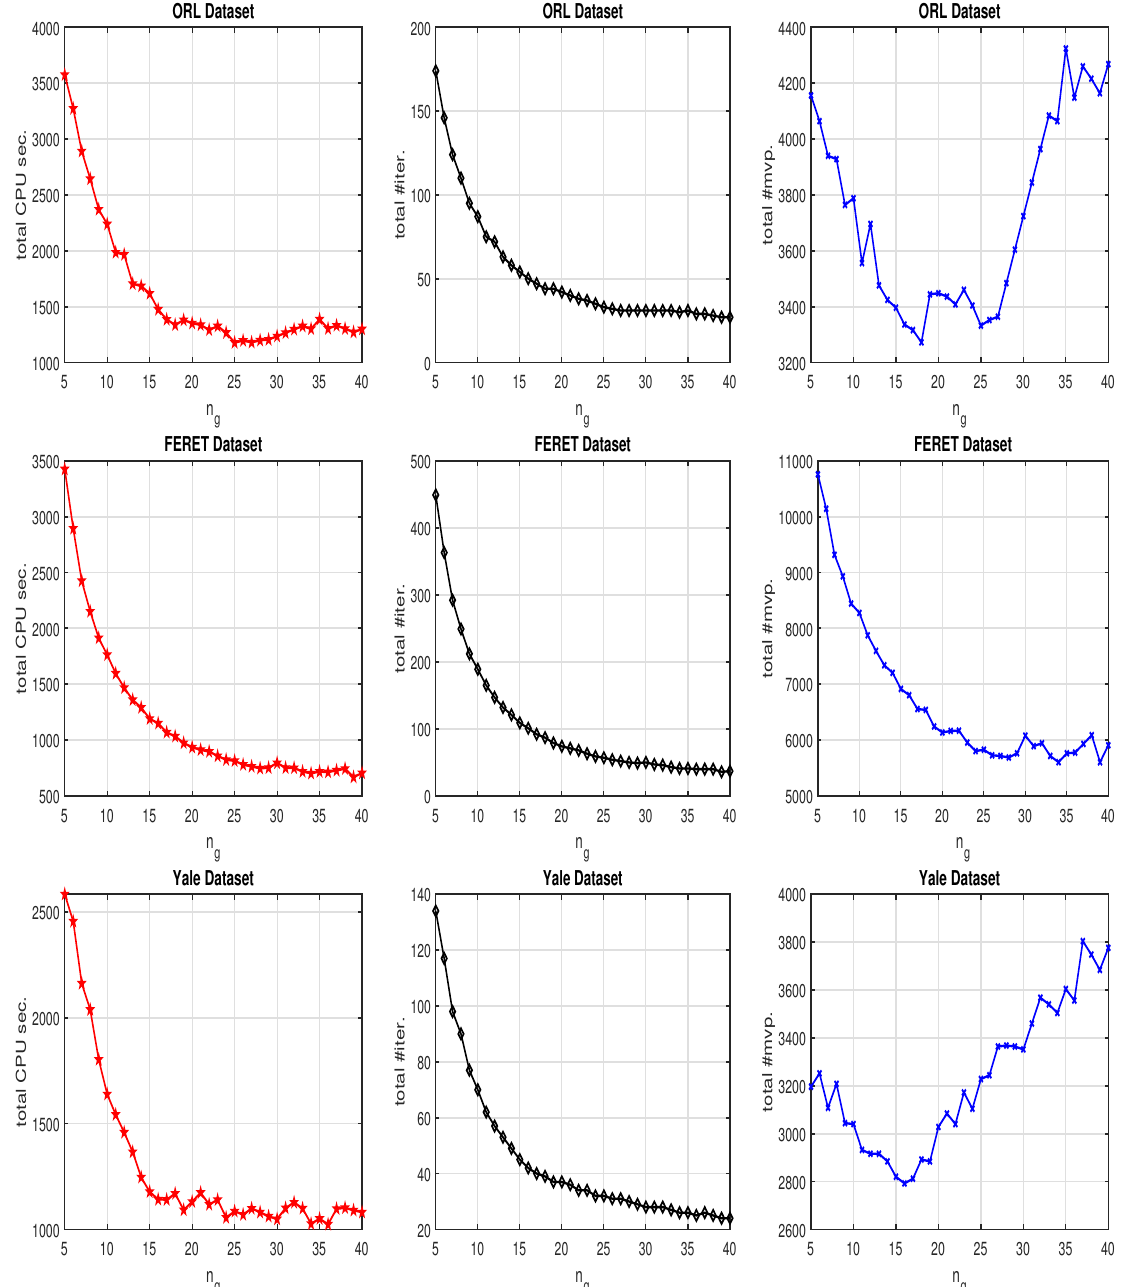
Figure 2. Cost in computing the first 10 canonical weight vectors of ORL ( top ), FERET ( middle ) and Yale ( bottom ) datasets with MINRES steps for the correction equation varying from 5 to